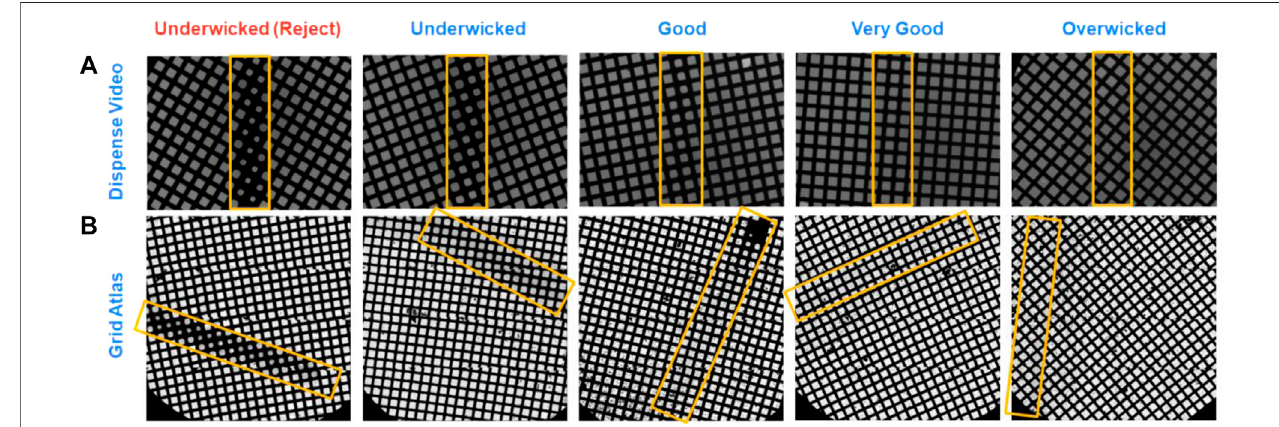
FIGURE7| Comparisonofgridsjustpriortofreezingonachameleonandafterimagingonacryoelectronmicroscope.Inbothtwo-stripeandone-stripemodes,a video is recorded between sample application and grid freezing that allows the user to judge if the desired fi lm thickness has been obtained. There are fi ve categories a grid can fall into based on its wicking state (A) . The (B) shows the corresponding grids as imaged on a cryo electron microscope demonstrating the correlation in ice thickness. Stripes in the chameleon dispense video are centrally located and vertical (marked by yellow boxes), whereas the corresponding stripes during imaging (marked by yellow boxes) are randomly located relative to the microscope cryobox and